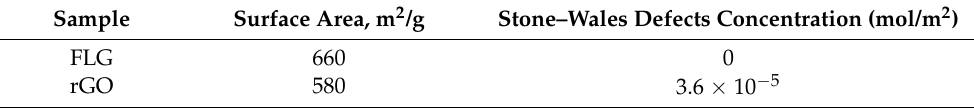
Table 3. Surface area and Stone–Wales defects concentration in FLG and rGO samples.